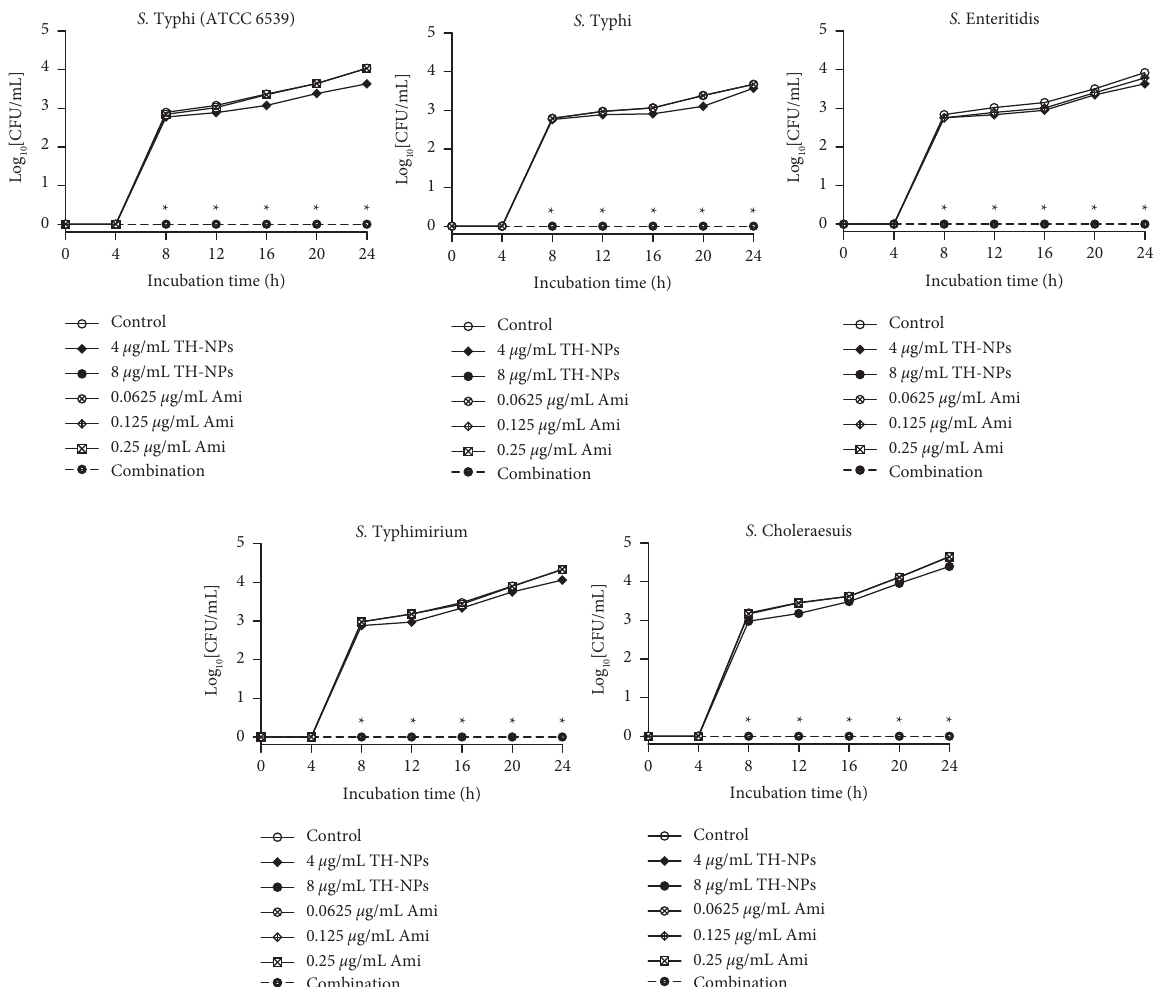
Figure 4: Time-kill kinetic assay of TH-NPs and amikacin alone or in combination against bioflm biomass formation of S. enterica serovars. TH-NPs: thymol-loaded PLGA nanoparticles; Ami: amikacin. Data represent the average values and standard deviation of three in- dependent experiments. ∗ Signifcant diference between the combination and TH-NPs alone ( p < 0.05